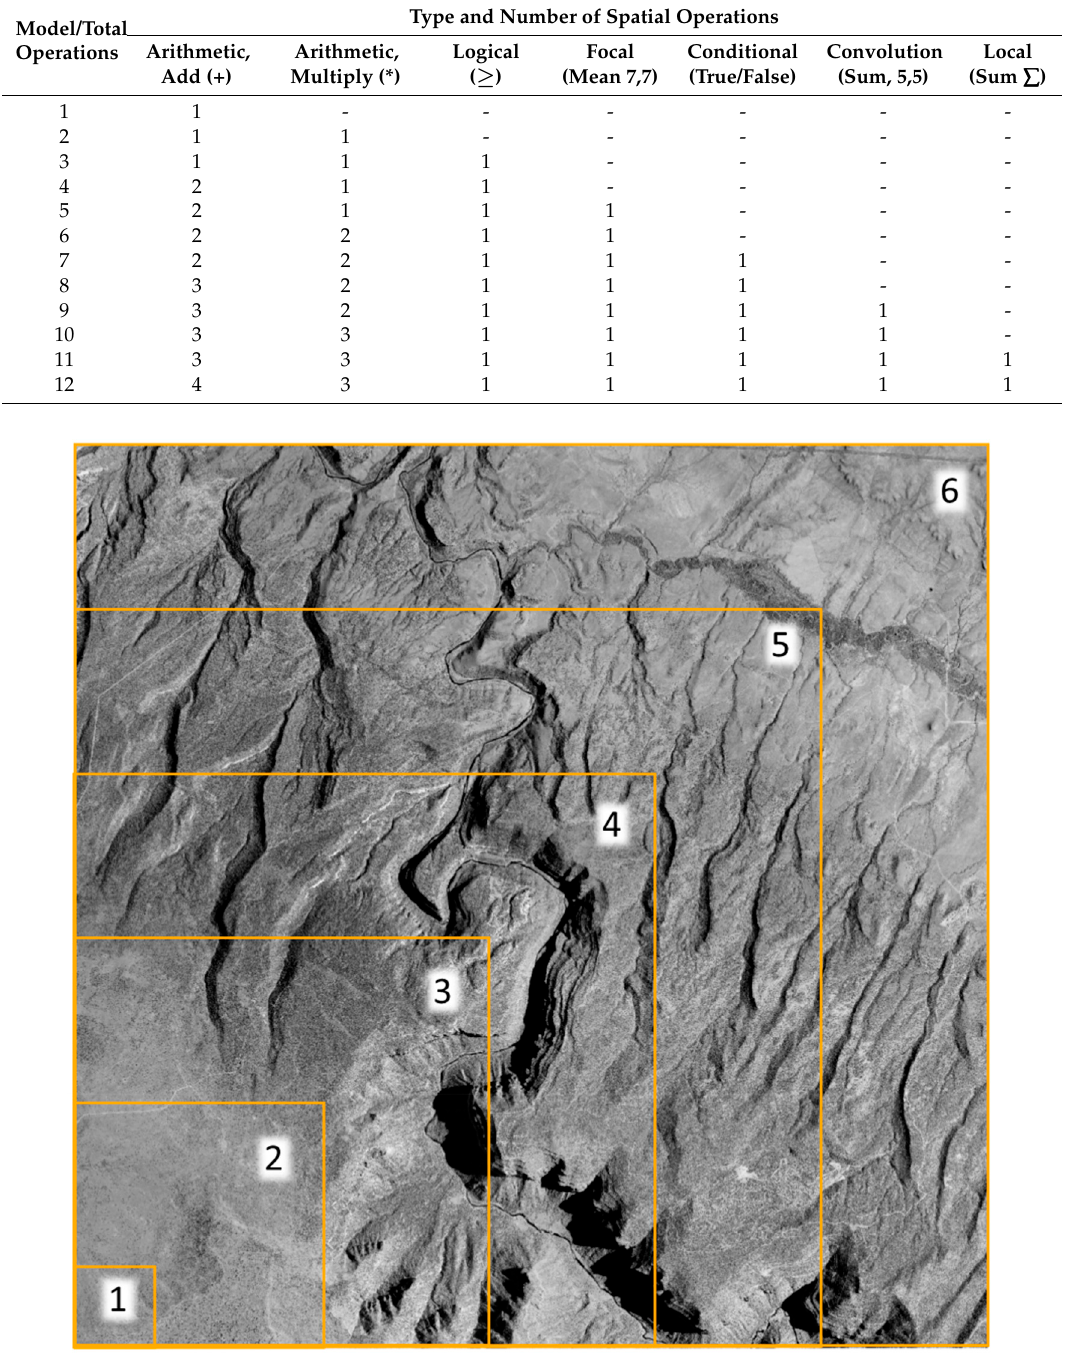
Table 1. The 12 models and their spatial operations used to compare and contrast function modeling and conventional raster modeling in the simulations. Model number (column 1) also indicates the total number of processes performed for a given model. Each of the six simulations included processing all 12 models on increasingly large data sets.